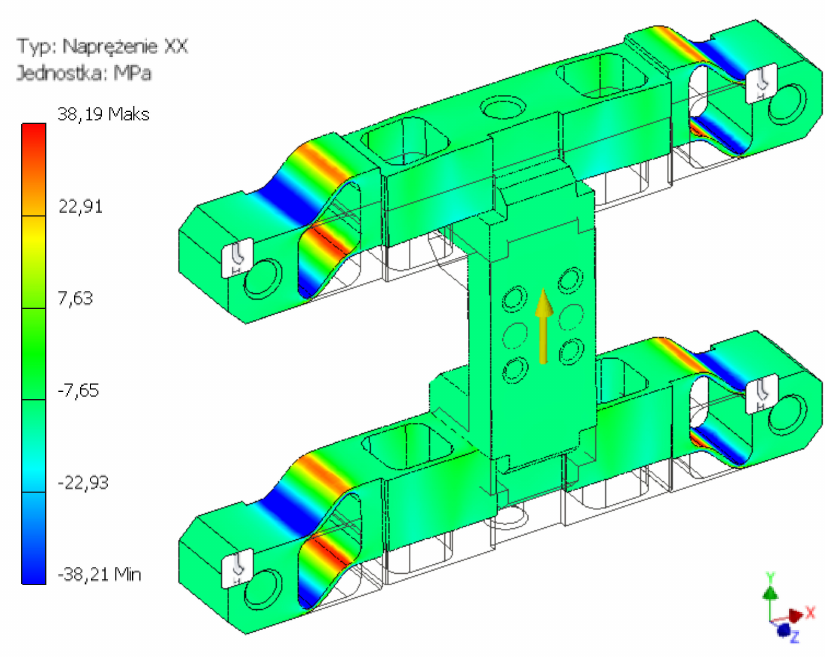
Figure 9. H-M-H strain map for the force value of 200 N acting along the Y